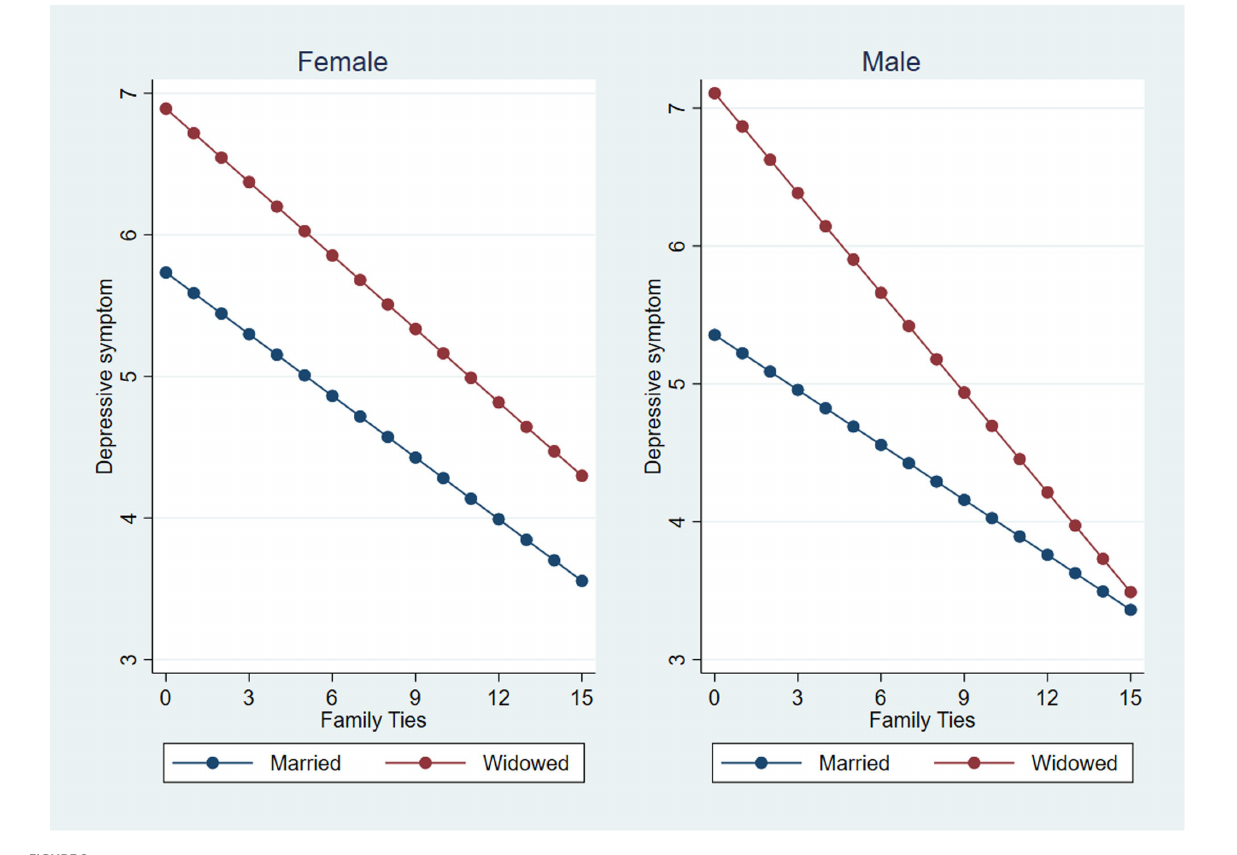
FIGURE 2 The moderating effect of family ties on the widowhood and depressive symptoms association among female and male older